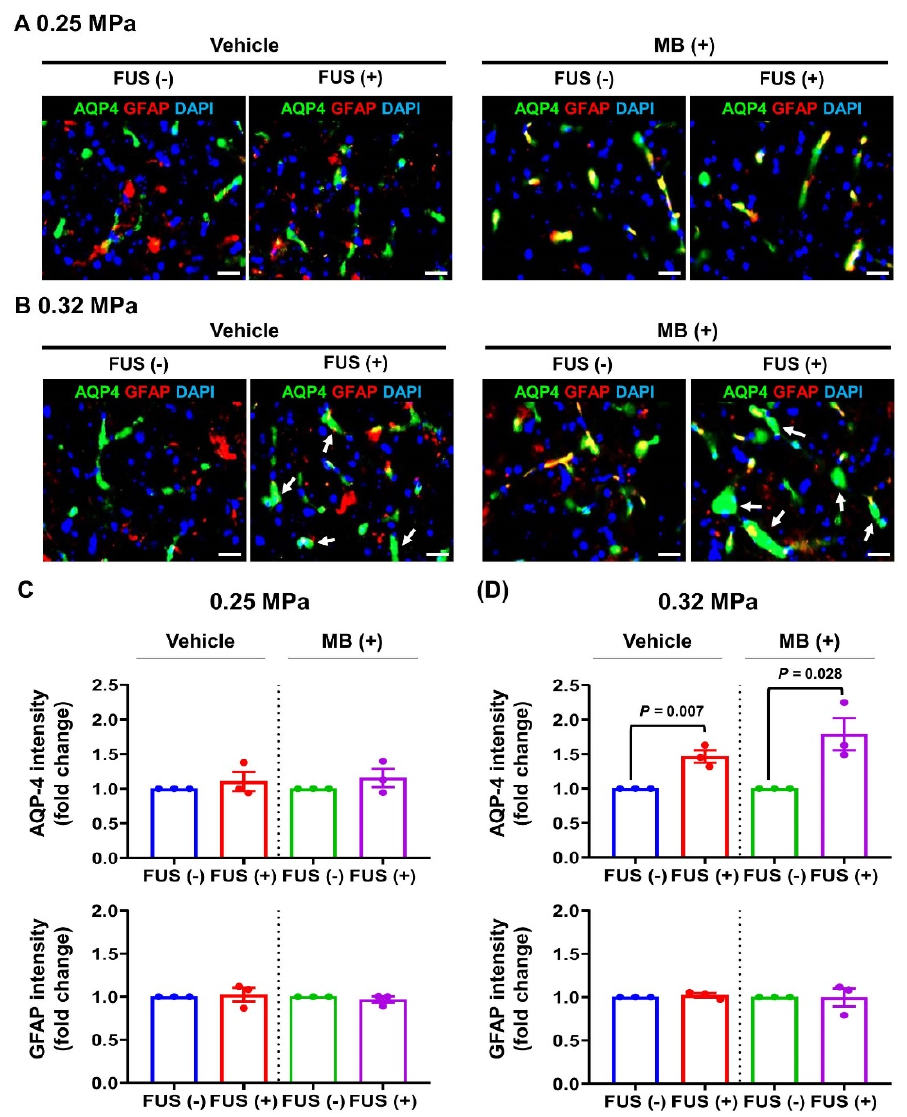
Figure 5. Changes in astrocytic AQP-4 expression in FUS-treated and FUS/MB-treated APP/PS1 mice. ( A , B ) Representative immunofluorescence images showing AQP-4 (green, a water channel protein) and GFAP (red, an astrocyte marker) intensities in the 0.25 MPa ( A ) and 0.32 MPa ( B ) groups. White arrows indicate upregulated AQP-4 expression (green). ( C , D ) The relative fluorescence intensity of AQP-4 ( C and D , upper) and GFAP ( C and D , bottom) was measured from 6 ROIs per hemisphere and normalized using the relative fluorescence intensity values from the non-FUS region. Data in the bar graph are presented as mean ± SEM (N = 3). Statistical significance was analyzed using a two-tailed unpaired t -test. Scale bars represent 20 µ m in ( A , B